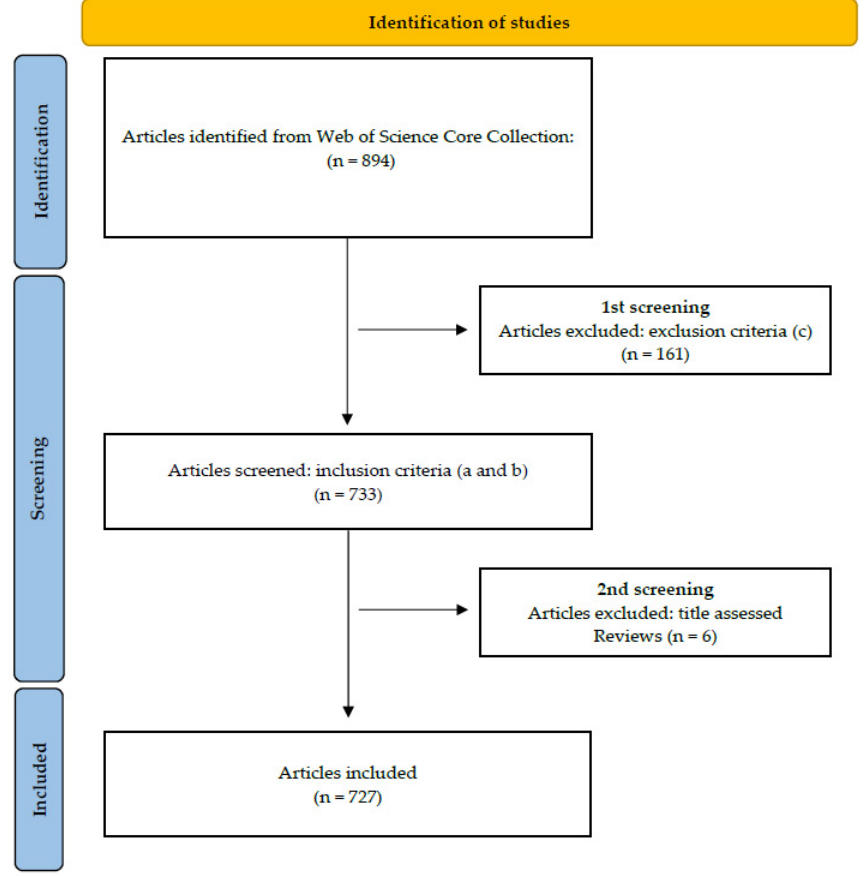
Figure 2. Flowchart of the results of the search according to the PRISMA standard (adapted version). (a–c): inclusion and exclusion criteria (see Section 2.1).